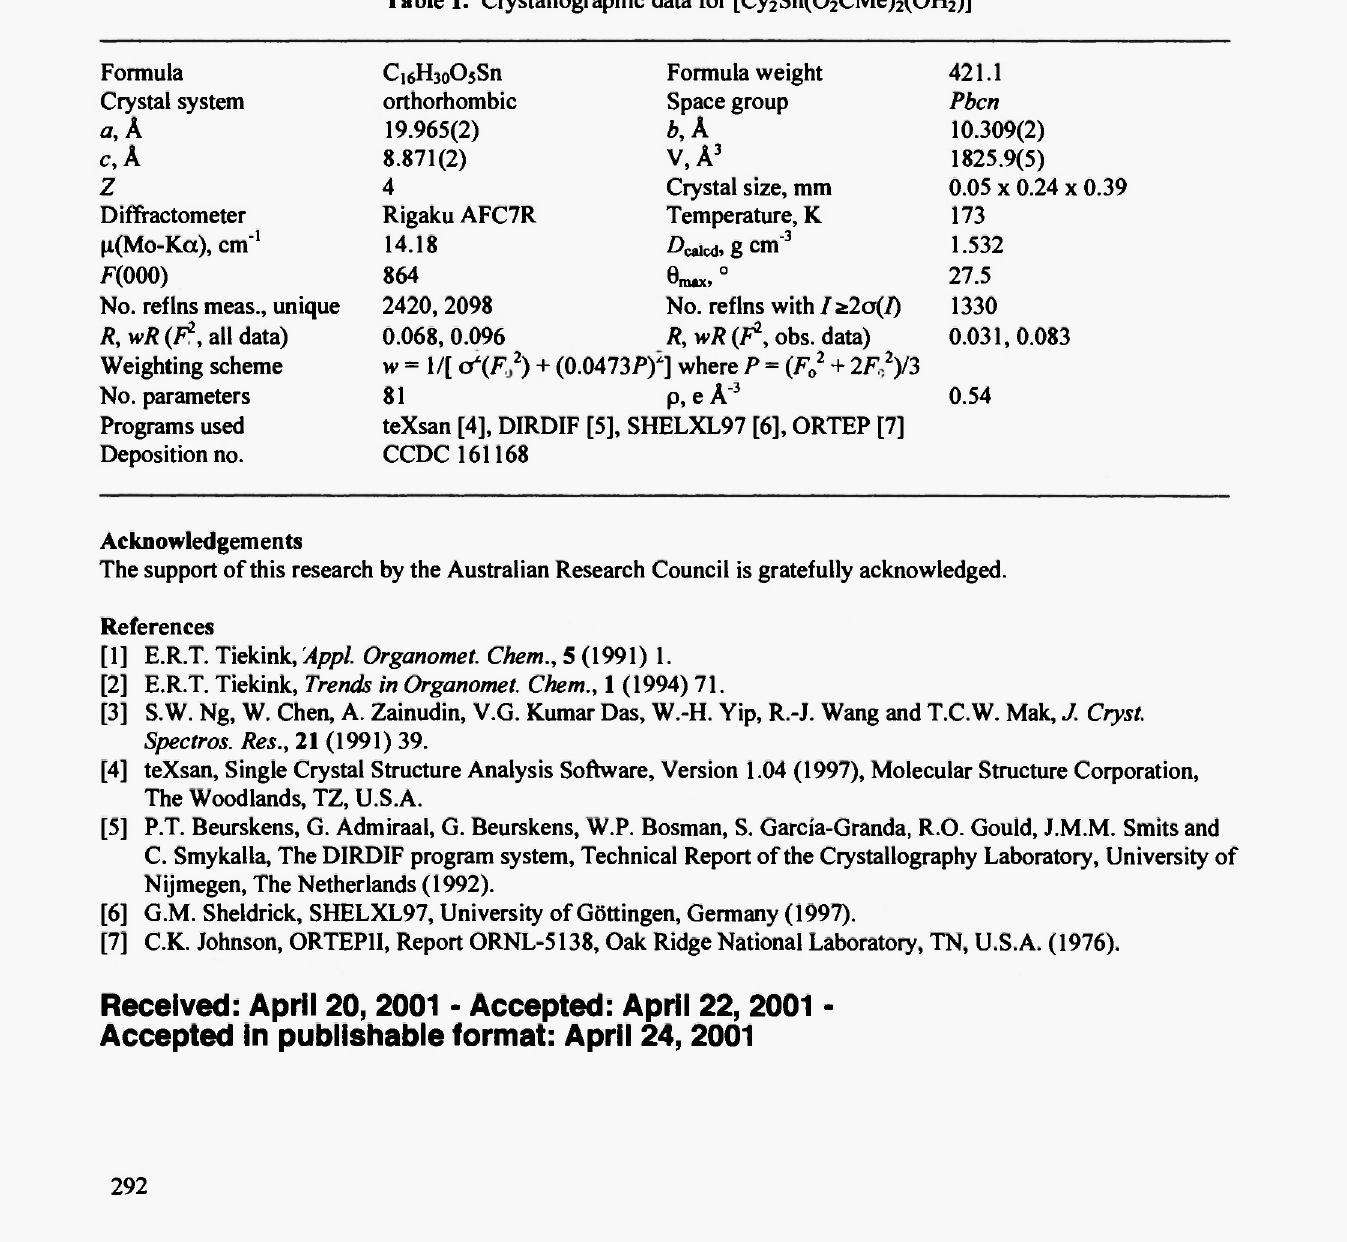
Table 1. Crystallographic data for [Cy